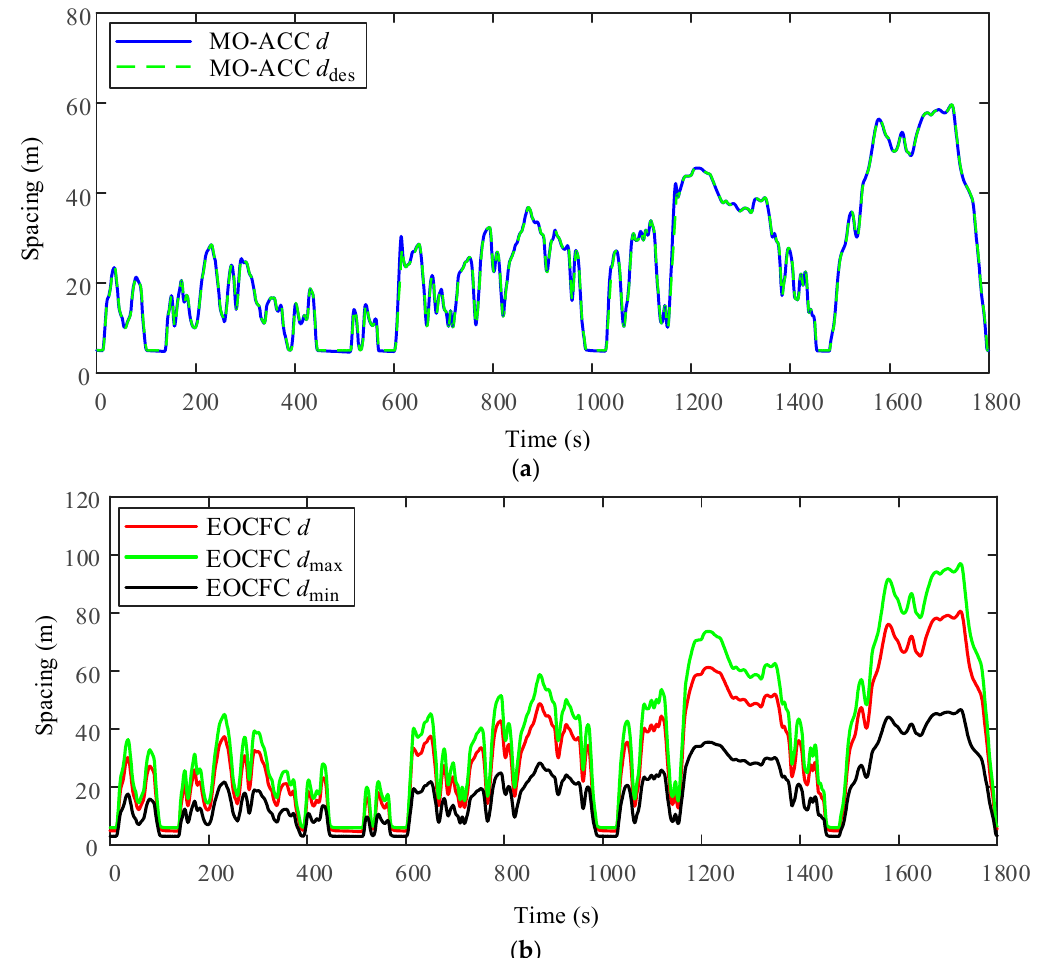
Figure 8. Speed profile of the host vehicle resulting from the MO-ACC strategy and the EOCFC strategy under the WLTC test cycle.